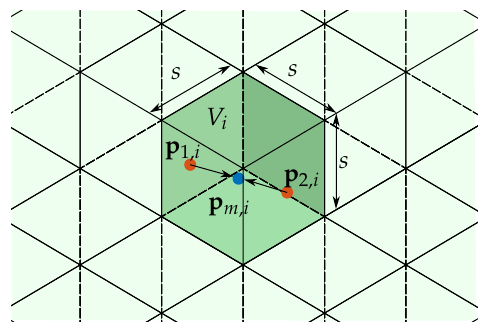
Figure 9. Process of merging points inside one